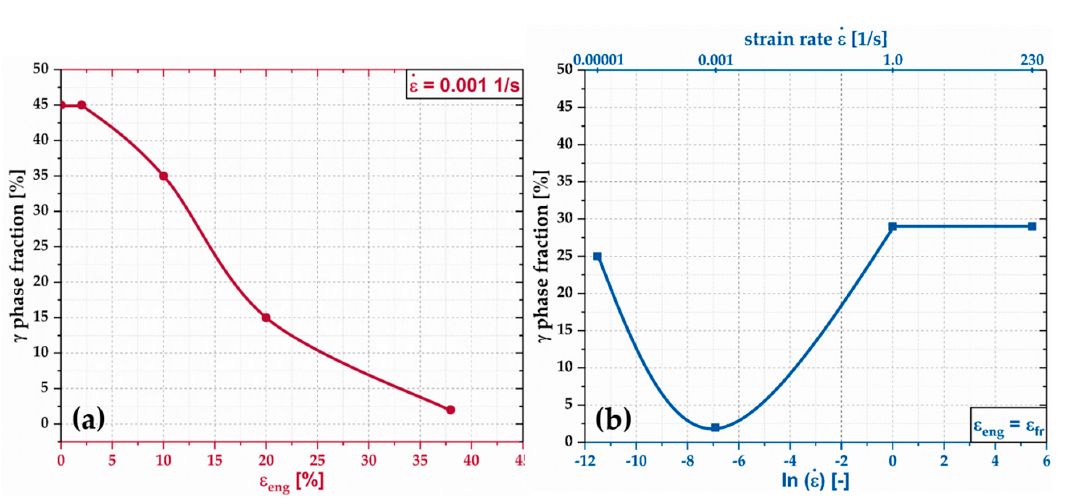
Figure 12. Summary of the evolution of γ phase fraction ( a ) during straining at 0.001 1/s and ( b ) comparison of strain-rate-dependent γ phase fractions after fracture.